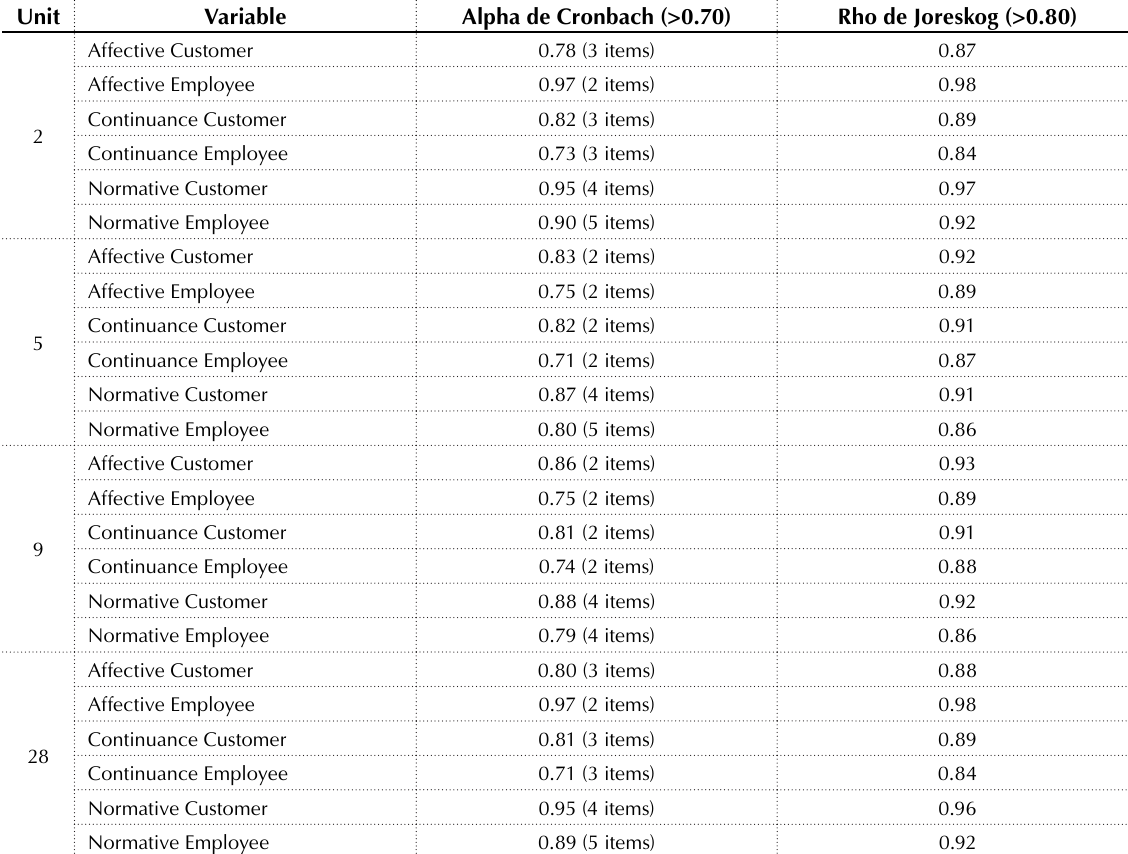
Table 1: Convergent validity (consistency) for the 4 units